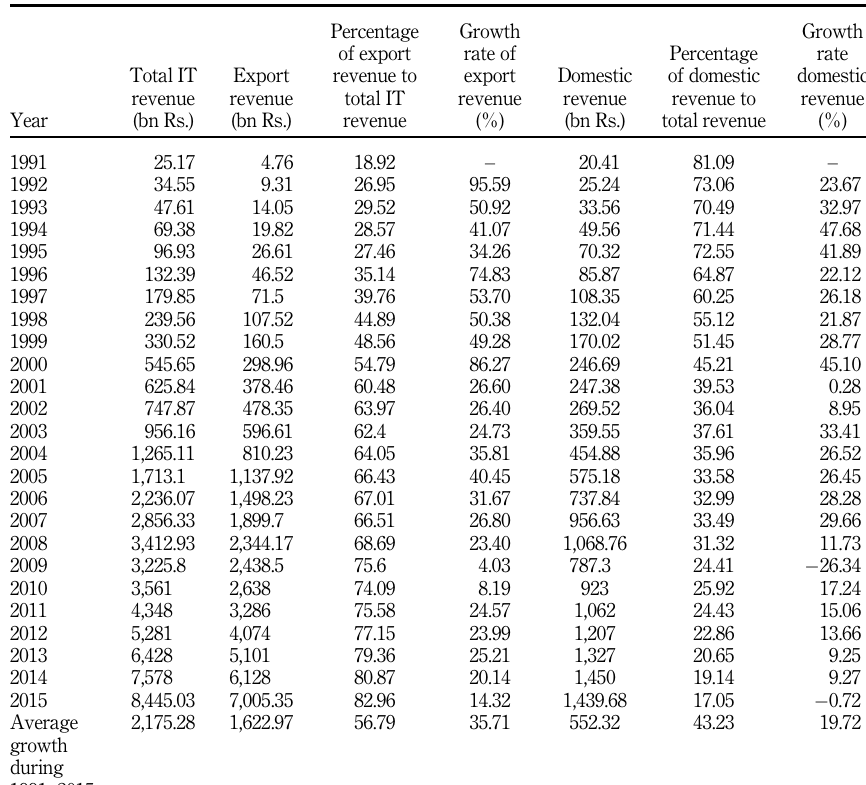
Table 2. Trends in export, domestic and total revenue of the Indian IT